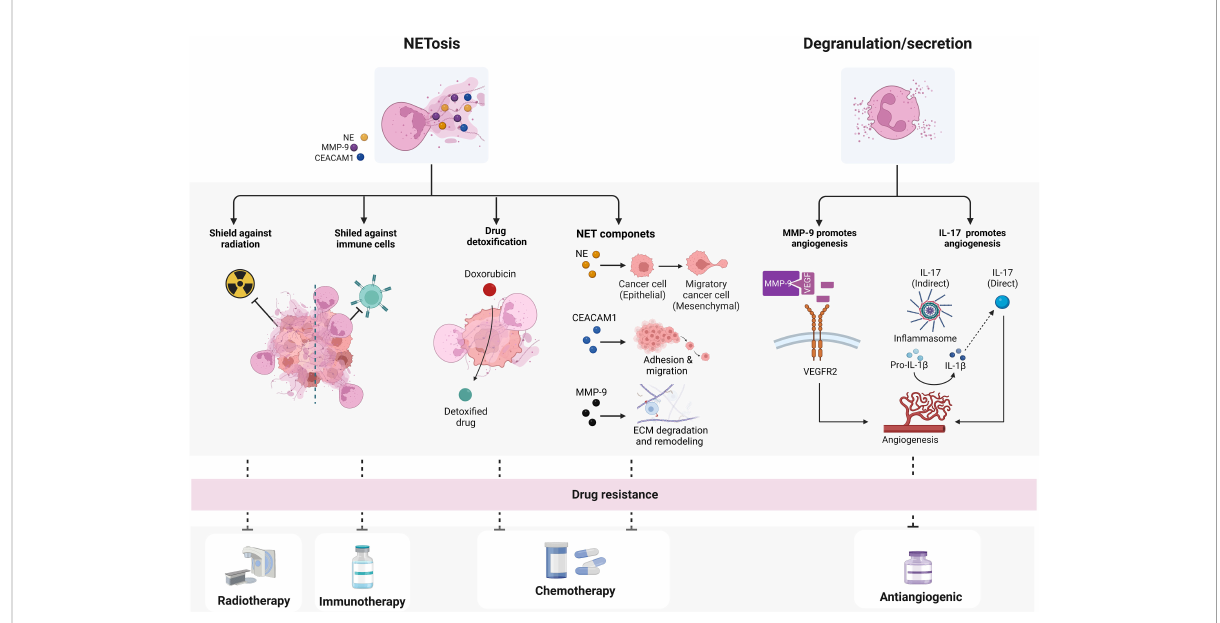
FIGURE 3 Mechanisms by which TANs may confer drugs resistance. TANs can promote drug resistance through two main mechanisms: NETosis and degranulation/secretion. NETs or NETs components can mediate resistance to immune- radio- and chemotherapy, while neutrophil-secreted factors have been shown to mainly in fl uence angiogenesis and interfere with angiogenic therapies.